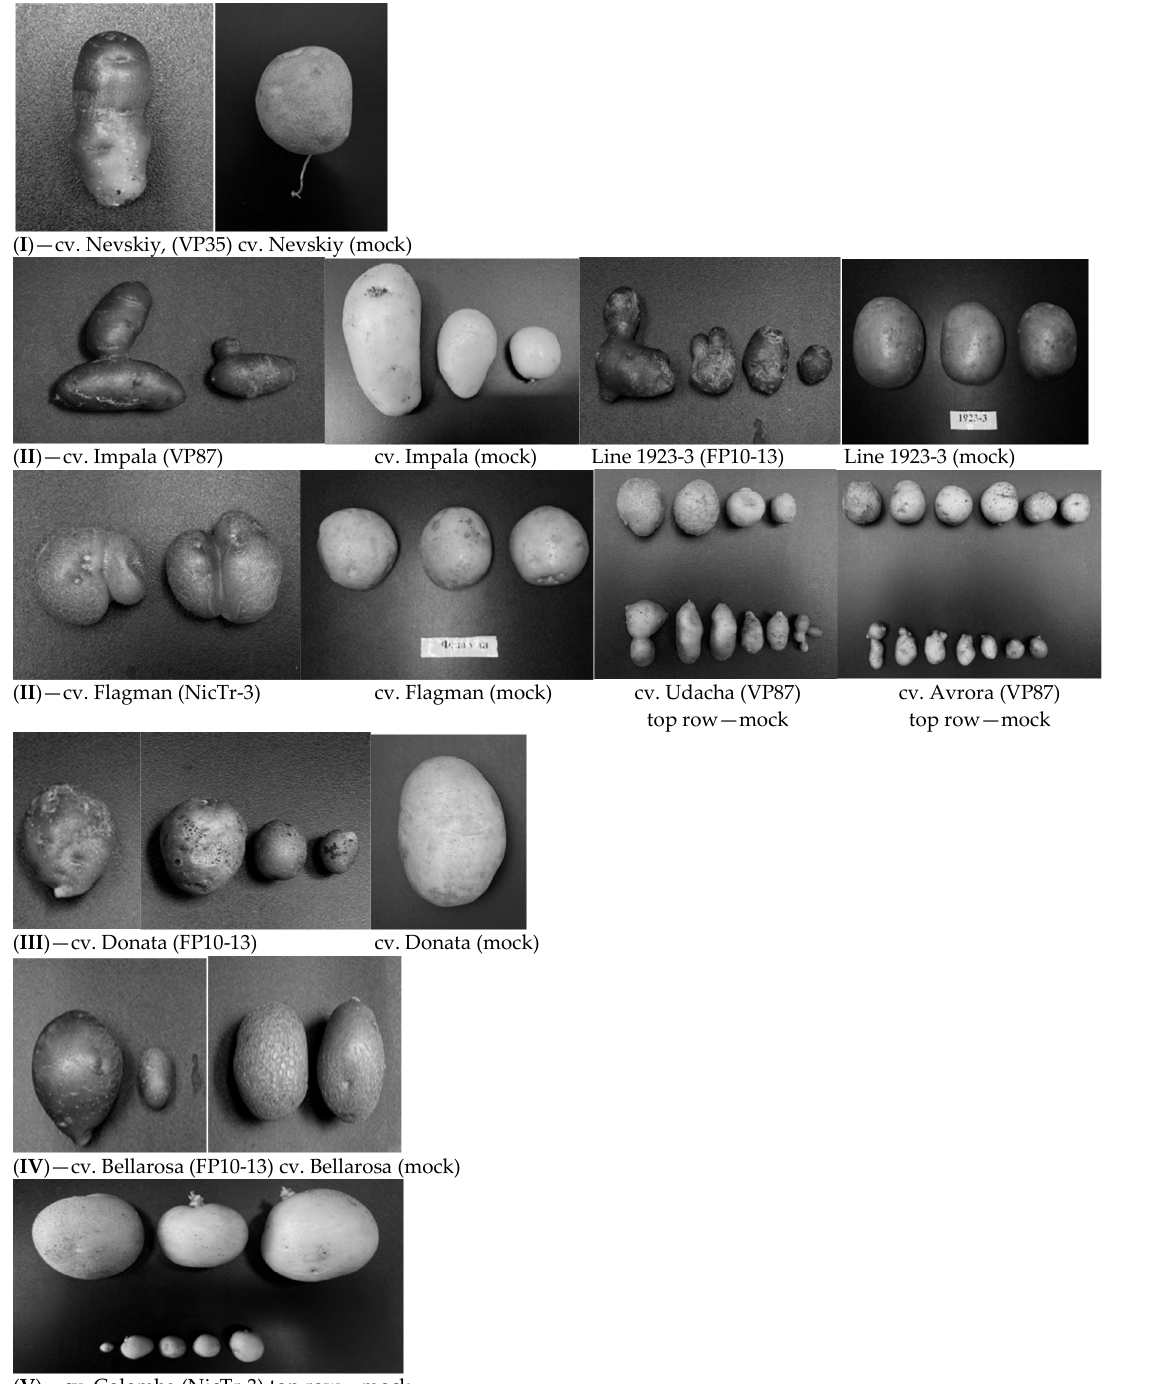
Figure 4. Symptoms on tubers of PSTVd-infected plants at 90 dpi: ( I ) — typical spindle-shaped; ( II ) — tubers malformation; ( III ) — pressed eyes on a potato tubers and deep stroking on the tuber; ( IV ) — pear-shaped and pointed end of tubers; ( V ) — significant reduction in tuber size (pea) compared to healthy plants.